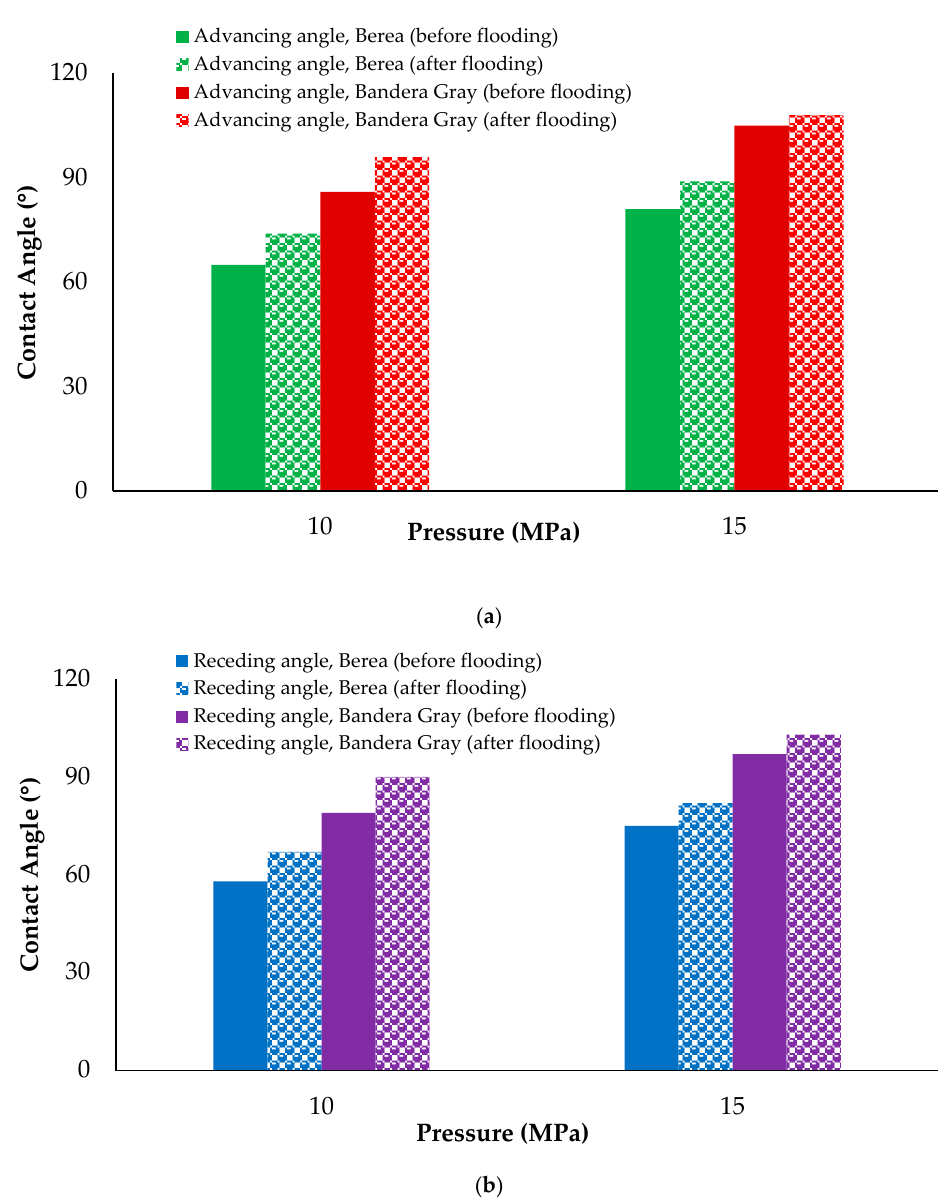
Figure 3. Berea and Bandera Gray sandstone/CO 2 /brine advancing ( a ) and receding ( b ) contact angles as a function of pressure (measured at 10 and 15 MPa, and 323 K).